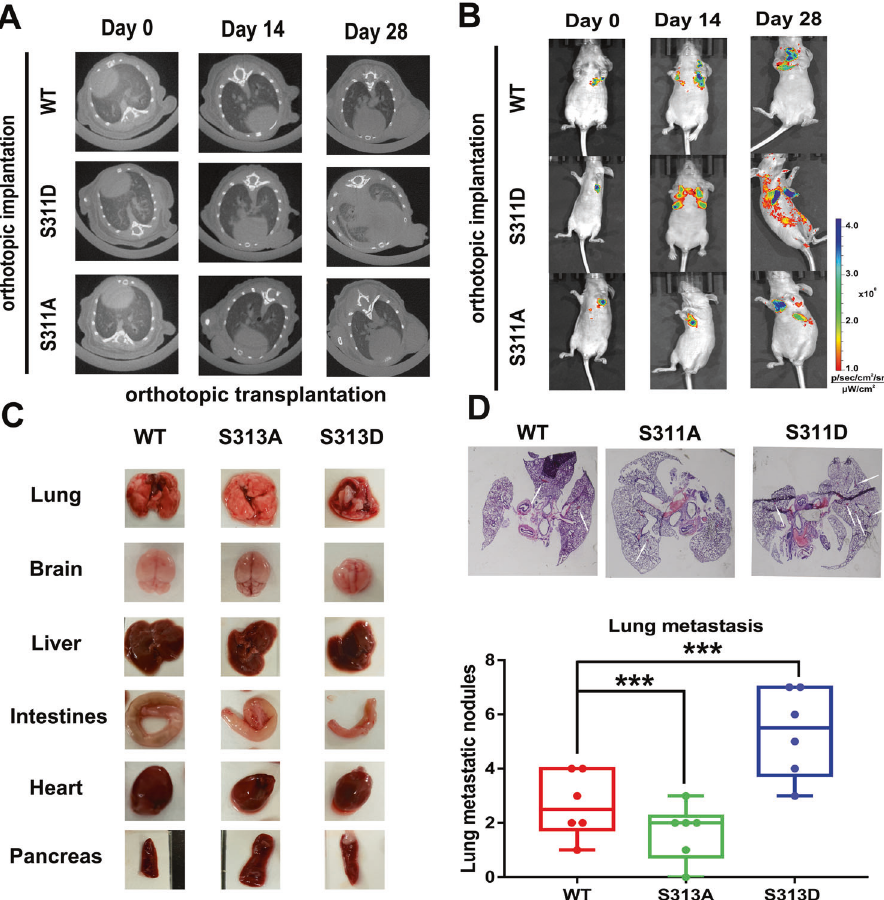
Fig. 5 Clip170 phosphorylation promotes breast cancer invasion and migration in vivo. A For the orthotopic implantation assays, bioluminescent images of systemic metastases in nude mice with Clip170-WT, Clip170-S311A, and Clip170-S311D MDA-MB-468 cells are shown. Bioluminescence calibration bar, 1.0 × 10 8 – 1.0 × 10 9 . B Representative images of the micro CT analysis of lungs from nude mice in the orthotopic implantation assay. C Representative images of lung, brain, liver, intestine, heart, and pancreas tissues from nude mice in